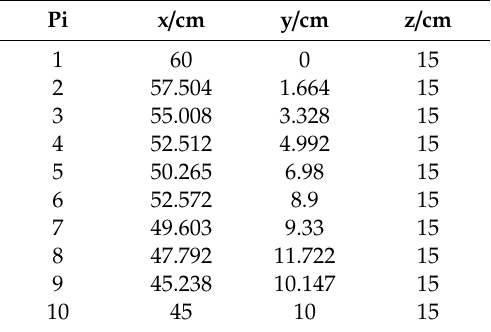
Table 8. Path points of the end-e ff